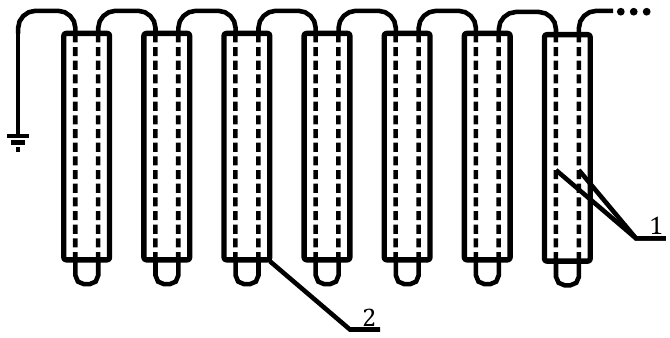
Figure 7. An example of a connection of shielding wires (1) placed in slot wedges